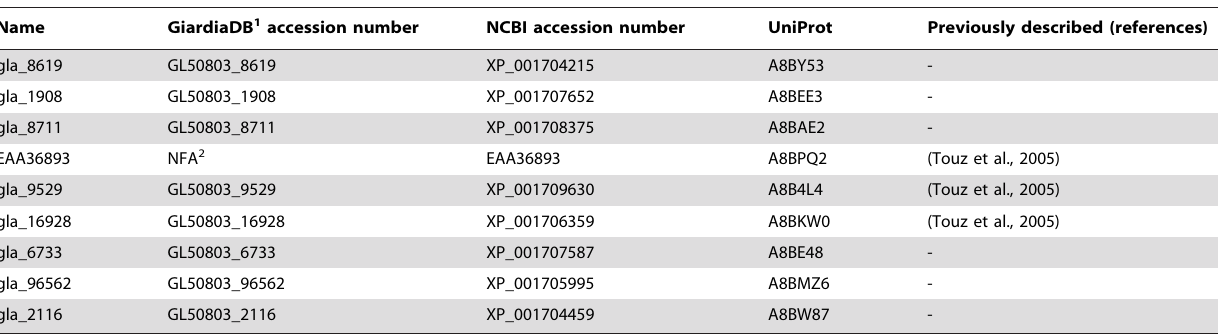
Table 1. Collection of DHHC proteins in Giardia lamblia